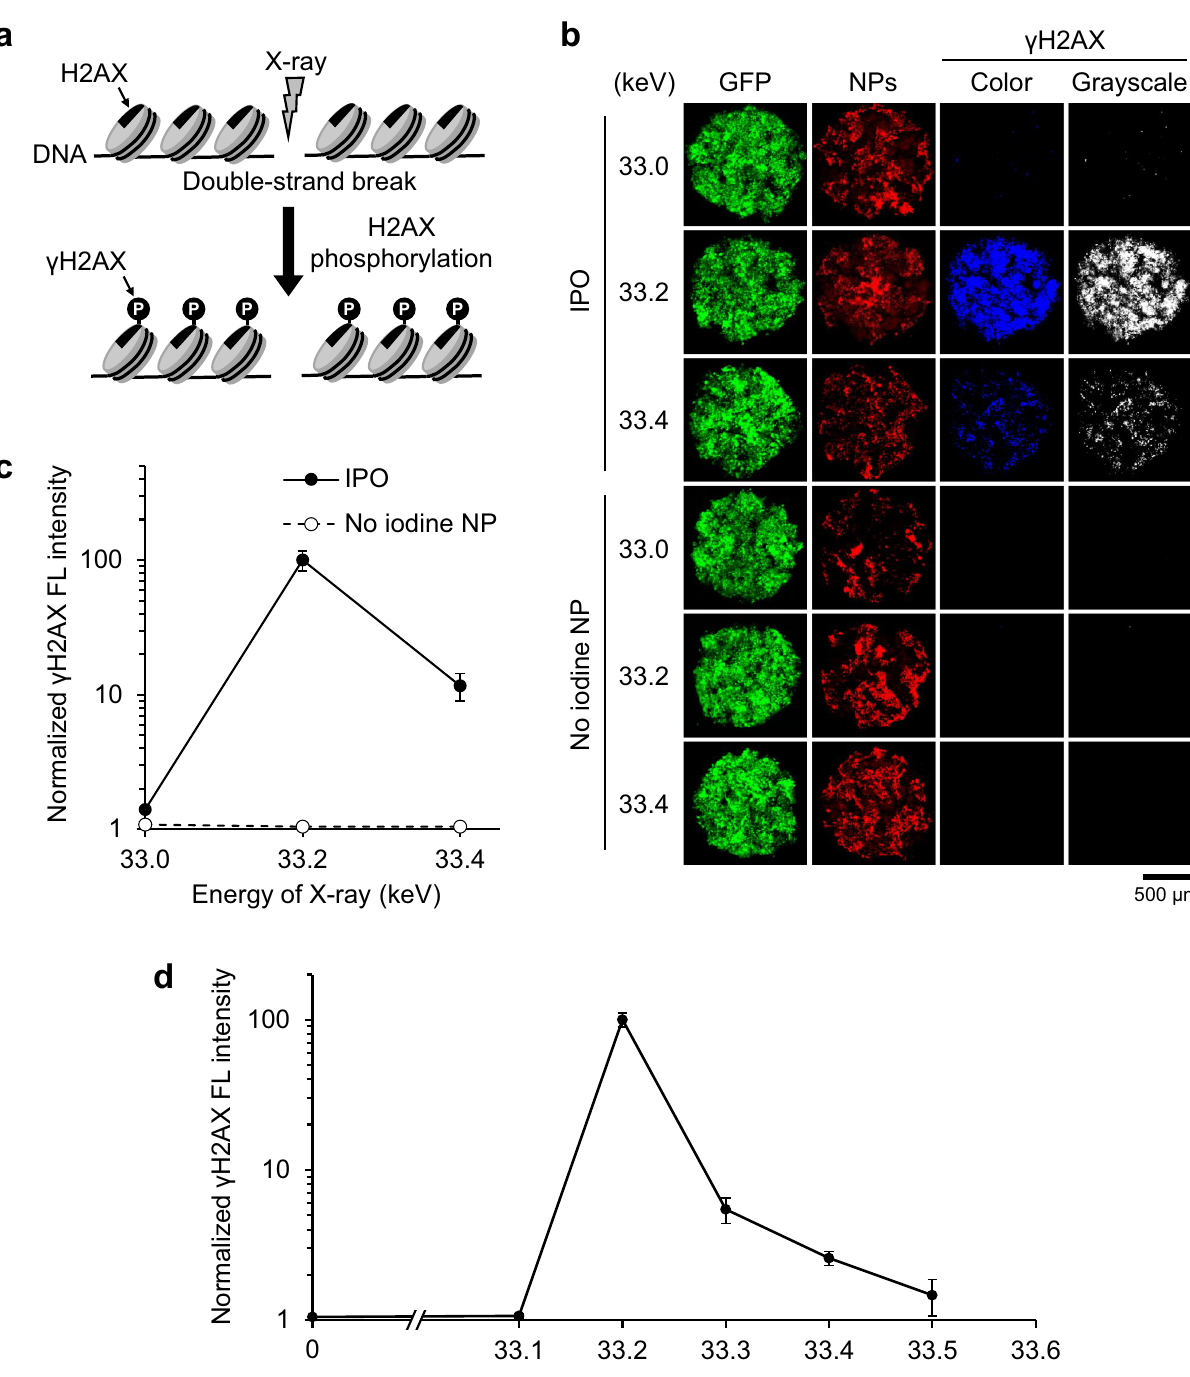
Figure 6. Detection of DNA double strand breaks in tumor spheroids. ( a ) An assay to detect double strand DNA breaks. ( b ) OVCAR8 tumor spheroids incubated with IPO or nanoparticles without iodine were irradiated with 33.0, 33.2 and 33.4 keV monochromatic X-rays for 30 min. After irradiation, spheroids were fixed immediately and γH2AX foci assay was performed. Images of γH2AX foci reflecting DNA double strand breaks are displayed by blue (color) as well as by white (grayscale). Tumor spheroids incubated with nanoparticles that do not contain iodine (no iodine NP) were used as no iodine controls. Red fluorescence shows nanoparticles (NPs) labeled with rhodamine-B. ( c ) Quantitation of double strand DNA breaks plotted against the energy of X-ray. Mean ± s.e.m. ( n = 3). FL fluorescence. ( d ) Detection of double strand DNA breaks using X-rays with 0.1 keV interval. OVCAR8 tumor spheroids incubated with IPO were irradiated with monochromatic X-rays for 30 min. After irradiation, spheroids were fixed immediately and γH2AX foci assay was performed. Mean ± s.e.m. ( n = 3). FL